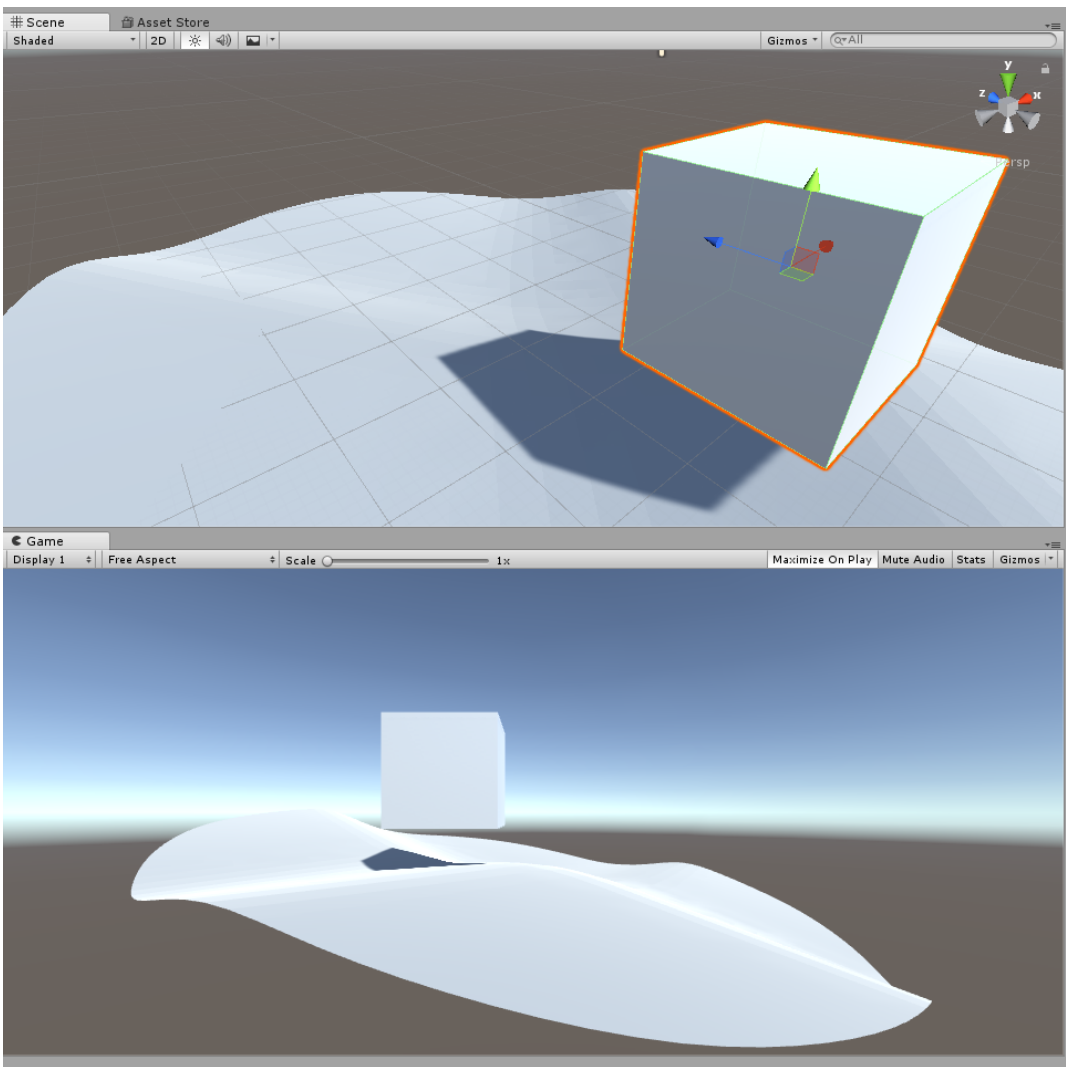
Figure 19. Non-planar “Floor